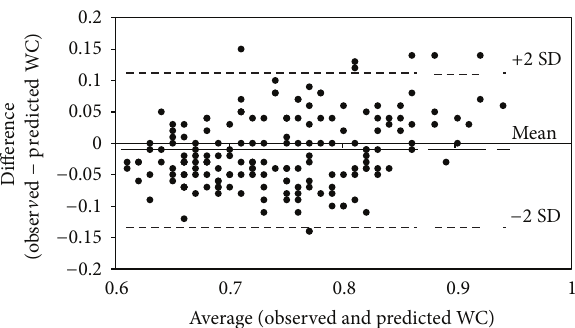
Figure 1: Bland Altman plot of WC differences between observed and predicted values. The solid line is at the bias and the dashed lines are at ± 95% limits of